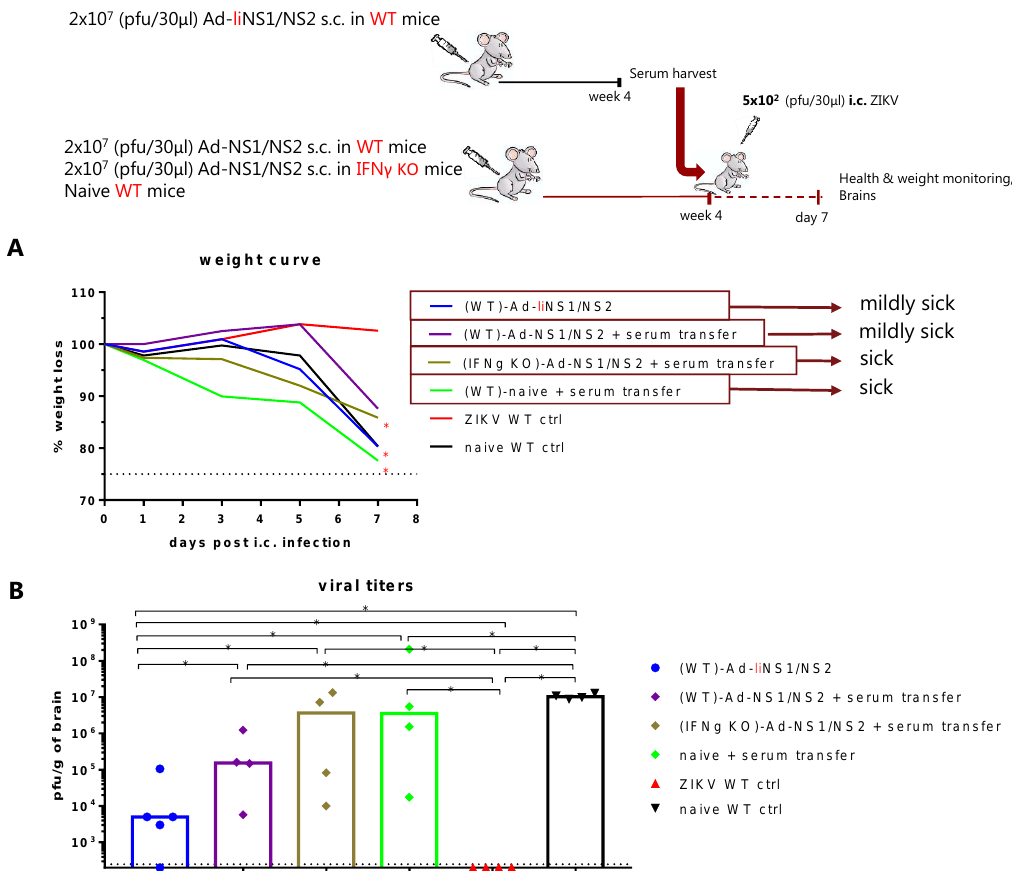
Figure 7. Mechanism of protection resulting from Ad-liNS1/NS2 vaccination. WT C57BL/6 mice were vaccinated s.c. with 2 × 10 7 pfu of Ad-liNS1/NS2 and four weeks later, serum was harvested and transfused to Ad-NS1/NS2 vaccinated WT mice, Ad-NS1/NS2 vaccinated IFN γ KO mice, or naive recipient mice three and one day prior to i.c. challenge with 5 × 10 2 pfu ZIKV. A group of ZIKV-immune and naive mice were included for control. ( A ) All groups were weighed and monitored daily following i.c. challenge. ( B ) On day 7 post i.c. challenge, brains were removed and viral titers were determined by a standard plaque assay. The detection limit for virus in the brain was 250 pfu/g organ and is displayed as a stippled line. Each dot represents an individual animal. The columns represent the group medians. * p < 0.05. For the weight curves, error bars were omitted for clarity, instead, stars denote a statistical significant difference compared to the unvaccinated control